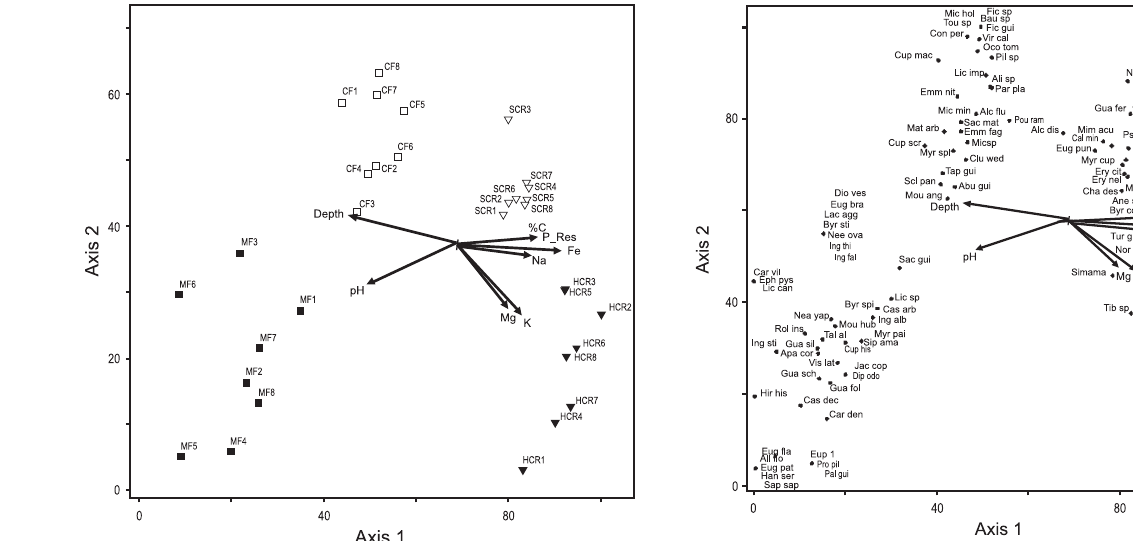
Figure 3. A canonical correspondence analysis (CCA) ordination of environmental variables and species abundance for plots from the four vegetation types at Serra Sul, Serra dos Carajás, Pará State, Brazil: herbaceous campo rupestre (HCR), shrubby campo rupestre (SCR), capão forest (CF), and montane forest (MF).